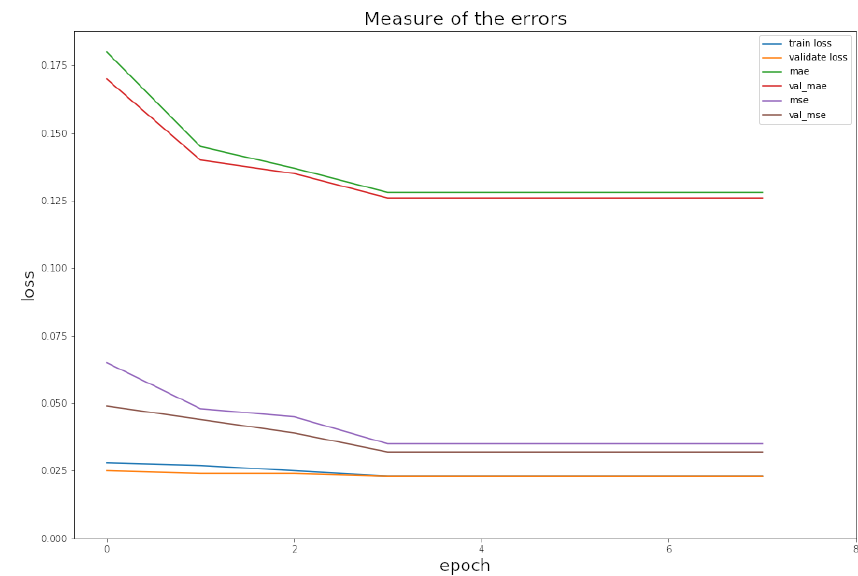
Figure 13. Graphical representation of the results of LSTM model